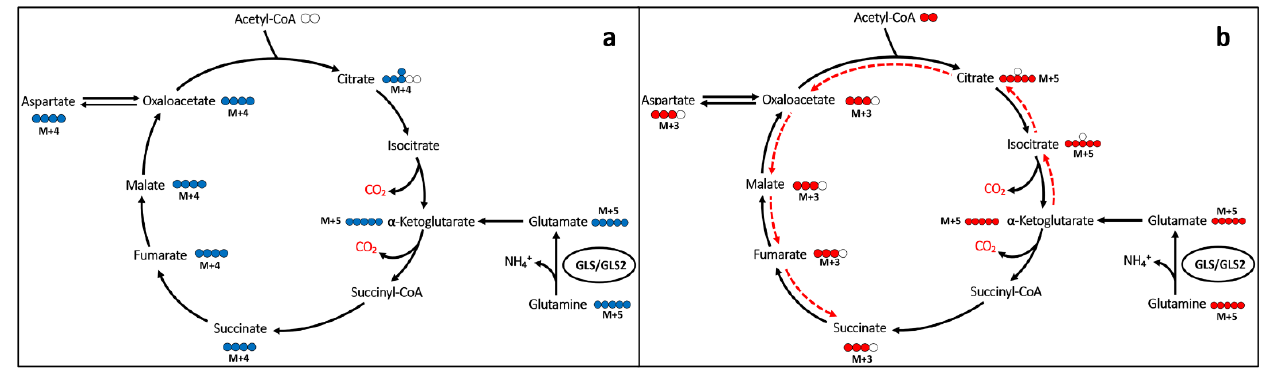
Figure 2. Simplified Gln carbon inheritance scheme (not showing all the reactions, cell compart- ments, enzymes or metabolites involved). Isotopomers of Gln allowed the specific quantification of Gln carbon contribution to citrate either following an oxidative ( a ) (m+4) or reductive ( b ) (m+5) pathway (labeling for the first turn is shown).